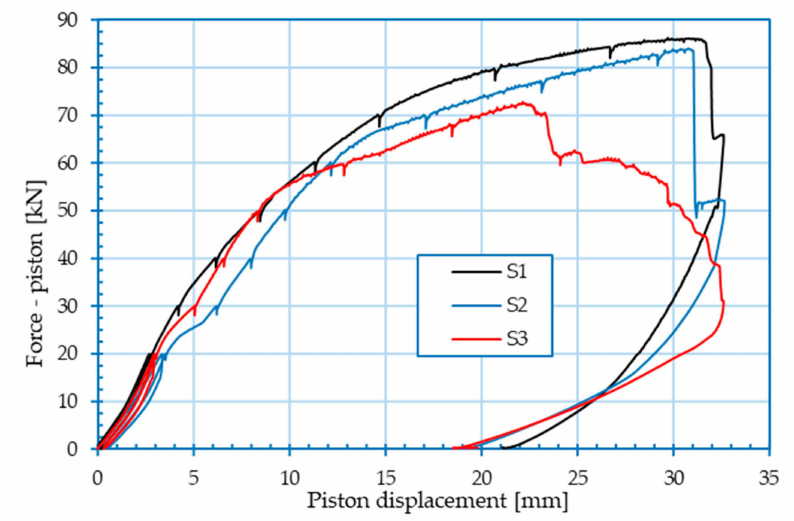
Figure 7. Force–displacement curves of the steel specimen measured in the piston.